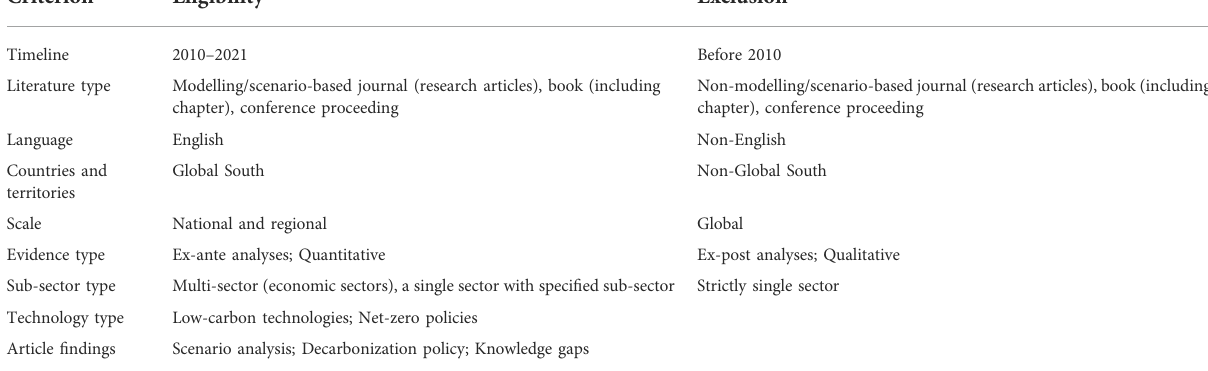
TABLE 1 The search string used for the systematic review